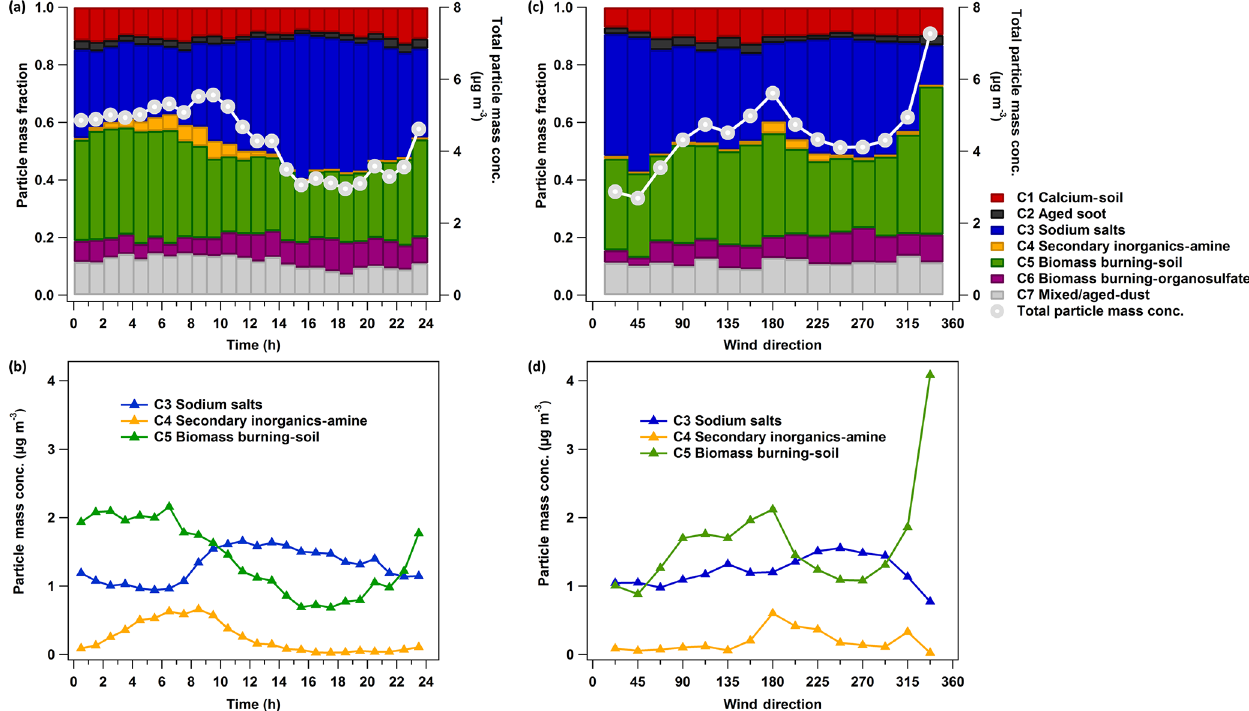
Figure 2. Diurnal pattern (a, b) and wind-direction-resolved particle class masses (c, d) measured by LAAPTOF. The data are averaged over the entire campaign. In total 4842 time points of 10min averaged data were analysed for these plots. The total particle mass concentration for each hour of the day is on average 4.3 ( ± 2 . 6, 1 σ )µgm − 3 and for each wind direction is on average 4.5 ( ± 2 . 9)µgm − 3 . For the dominating classes the average mass concentrations are 1.3 ( ± 1 . 1) and 1.2 ( ± 1 . 0)µgm − 3 for class 3, 0.2 ( ± 0 . 5) and 0.2 ( ± 0 . 4)µgm − 3 for class 4, and 1.4 ( ± 1 . 0) and 1.6 ( ± 1 . 5)µgm − 3 for class 5 in panels (b) and (d) . It is worthy to note that particle mass quantification is one of the